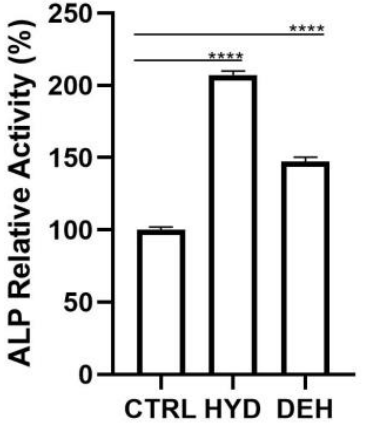
Figure 7. ALP activity of osteoblasts cultured for 7 days (**** p <